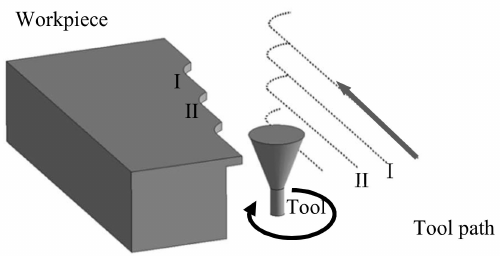
Figure 2. Cutter location for experiments in the case of up cut